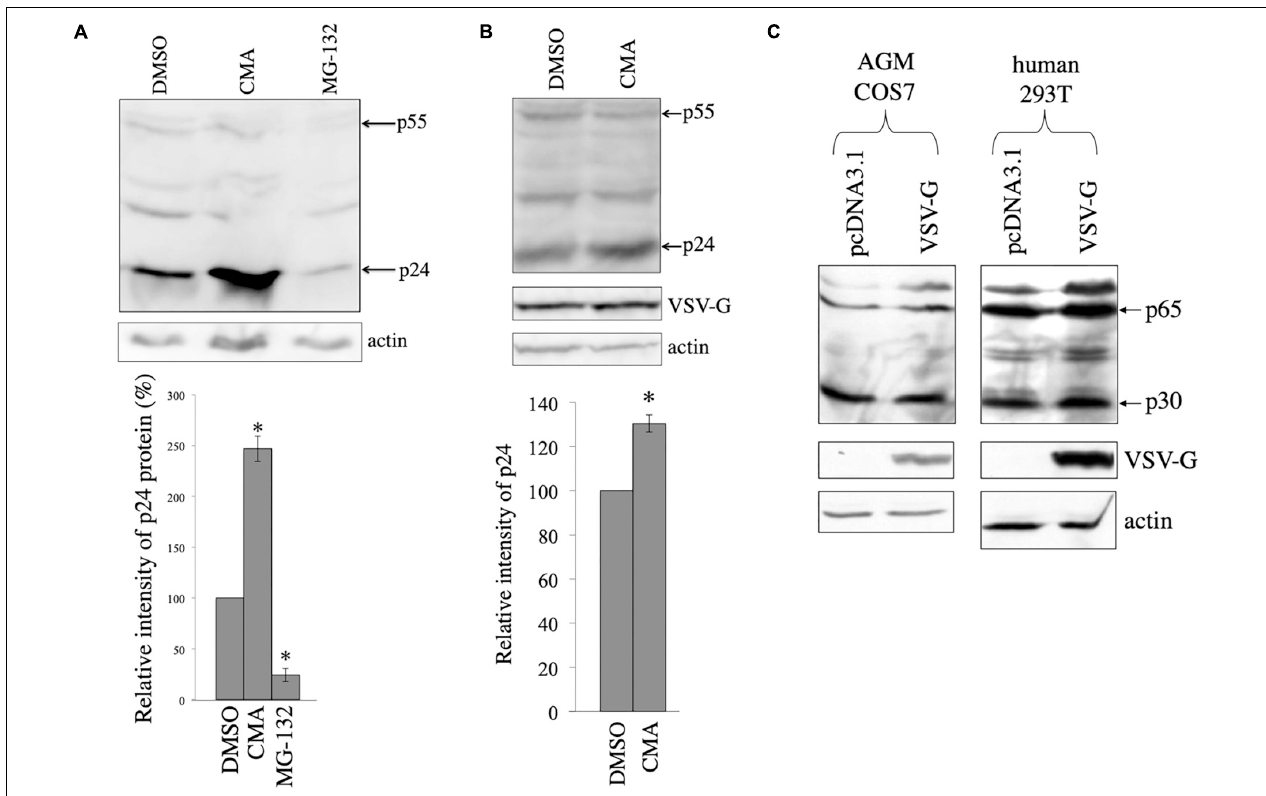
FIGURE 3 | HIV-1 Gag protein is digested in lysosomes and VSV-G rescues Gag protein from the digestion in COS7 cells. (A) COS7 cells were transfected with the HIV-1 Gag-Pol expression plasmid, and then were treated with DMSO, CMA, or MG-132. Cell lysates from the transfected cells were analyzed by western immunoblotting (upper panel). HIV-1 Gag precursor (p55) and mature capsid (p24) were indicated by arrows. Intensities of the p24 protein bands were measured by a densitometer. Relative values to the intensities in the pcDNA3.1-transfected cells are indicated (lower panel, n = 3). Asterisks show significant differences compared to DMSO. (B) COS7 cells were transfected with the HIV-1 Gag-Pol and VSV-G expression plasmids, and were treated with DMSO or CMA. Cell lysates prepared from the treated cells were analyzed by western blotting. Intensities of the p24 protein bands were measured by a densitometer. Relative values to the intensities in the pcDNA3.1-transfected cells are indicated (lower panel, n = 3). Asterisks show significant differences compared to DMSO. (C) AGM COS7 and human 293T cells were transfected with the MLV Gag-Pol expression plasmid together with pcDNA3.1 or VSV-G expression plasmid. Cell lysates prepared from the transfected cells were analyzed by western blotting. MLV Gag precursor (p65) and mature capsid (p30) were indicated by